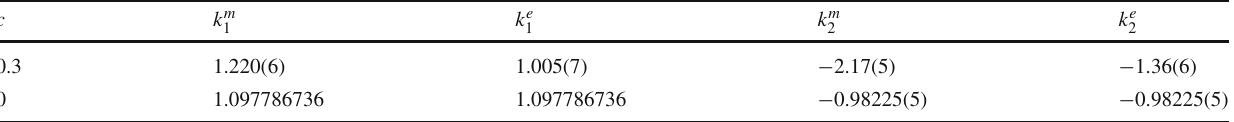
Table 1 Coefficients for the perturbative expansion of the magnetic and electric GF couplings for two values of c (see Eq. (2.31)). The finite-volume SF definition corresponds to c = 0 . 3, while c = 0 refers to the infinite volume definition of the